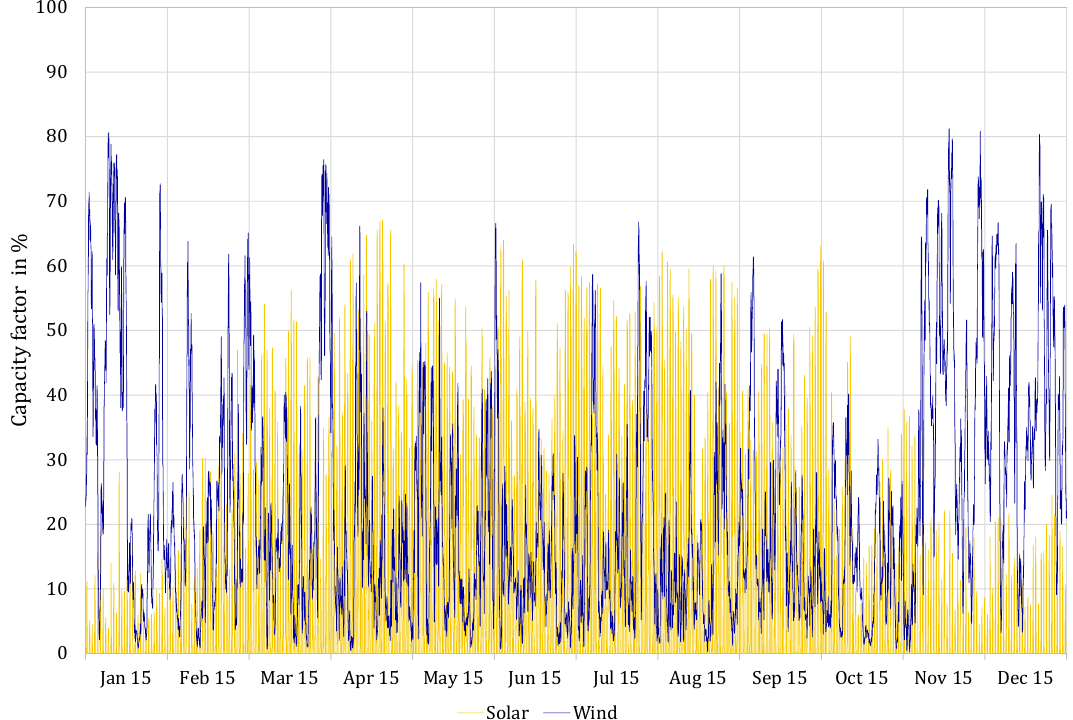
Figure 4. Input data for the model: solar (yellow) and wind (blue) power generation. The capacity factor represents the ratio of generated power to installed capacity.